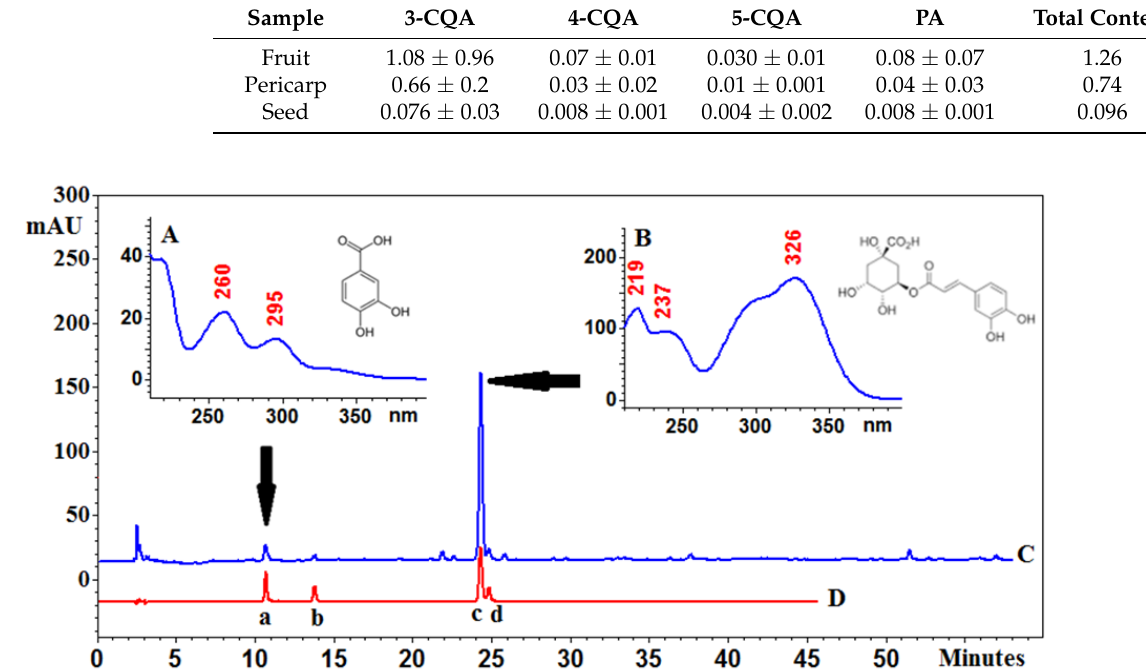
Figure 6. Chromatogram of Eleutherococcus senticosus fruits ( C ) and a mixture of reference standards ( D ): a—protocatechuic acid, b—neochlorogenic acid, c—chlorogenic acid and d—cryptochlorogenic acid with PDA spectra and structures of the main compounds: ( A )—protocatechuic acid and ( B )—chlorogenic acid. C18 core-shell column (Kinetex, Phenomenex, Aschaffenburg, Germany) (25 cm × 4.6mm i.d., 5 μm particle size) at 25 °C, a mixture of water (solvent A) and acetonitrile (solvent B) with 0.025% of trifluoroacetic acid; gradient elution program: 0.0–5.0 min A 95%, B 5%; 5–60 min A from 5 to 20%, and B from 95–80%. The flow rate was 1.0 mL/min.